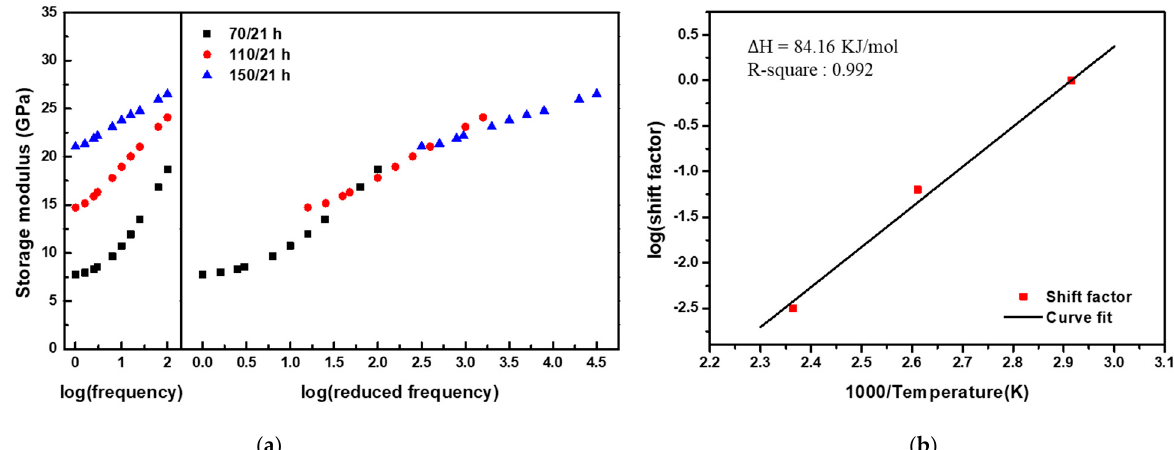
Figure 4. Thermomechanical behavior of AO-exposed CF-SMPCs. ( a ) Storage moduli measured as a function of frequency at a reference temperature of 70 °C using dynamic mechanical thermal analysis (DMA) and the master curve built at the reference temperature of 70 °C, and ( b ) shift factors for the master curve. Table 3. Thermomechanical properties and mass loss for five validation data sets in an AO envi- ronment.